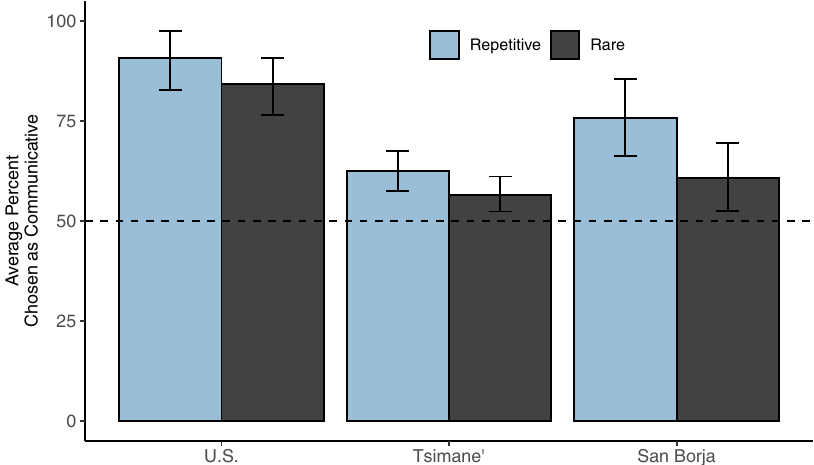
Fig. 6 Results from Study 5. Left to right: Average preference for the rare or repetitive video as communicative with US, Tsimane ’ , and San Borja participants. San Borja is the Spanish-speaking market-integrated town that is closest to the Tsimane ’ communities, which served as a geographic control. Each bar shows the average percentage of endorsements for rare or repetitive movement when directly contrasted with a basic one. U.S. ( n = 40) and San Borja ( n = 40) participants completed the task with the low punctuality demonstrator videos. Tsimane ’ participant results are combined across both low punctuality ( n = 120) and natural punctuality videos ( n = 60). Vertical lines show bootstrapped 95% con fi dence